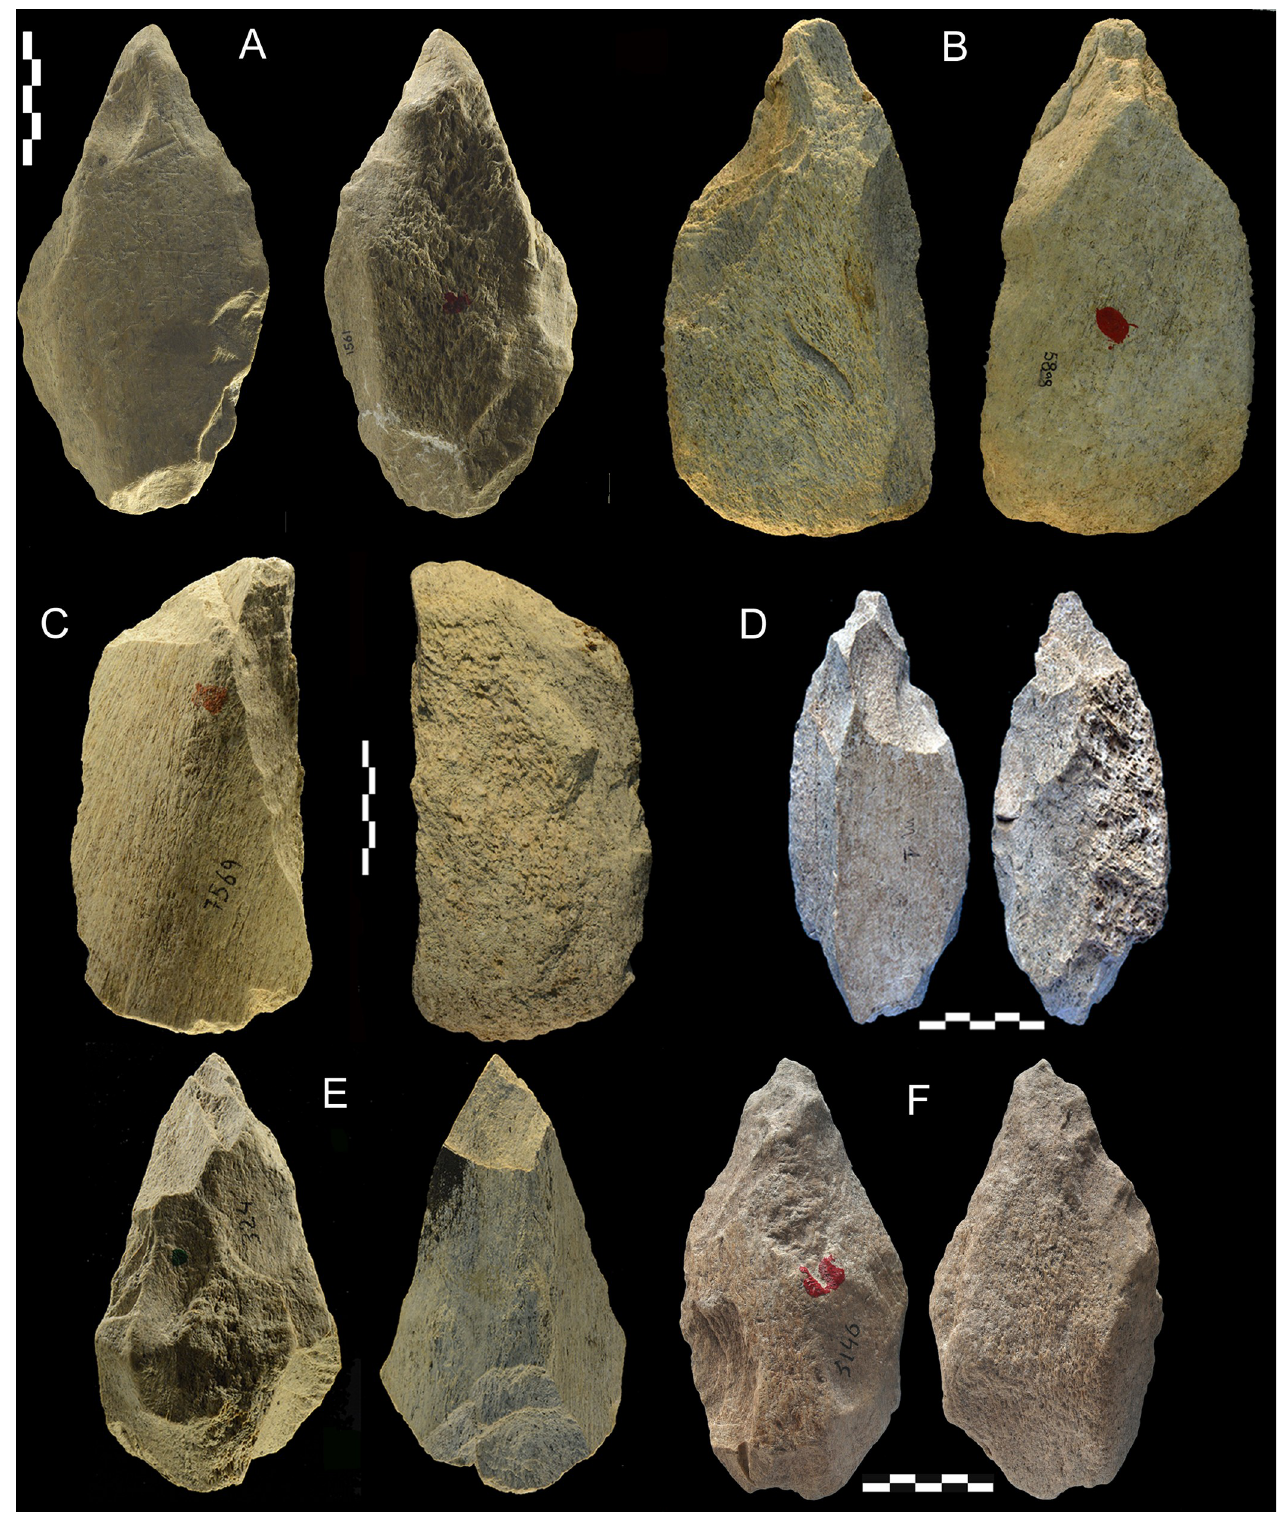
Fig 8. Castel di Guido. (A) biface; (B-F) partial bifaces. Catalogue numbers 1561, 5898, 7569, TM 10433, 324, 5146. Note that the partial bifaces B and E are abraded on one face and fresh or only slightly abraded on the other. This suggests that some large pieces were partly buried in sand and the exposed face (sometimes- but not always- indicated by a red or green dot assigned at excavation) was abraded in situ by the flow of sandy water. See similar occurrences in layer m of Torre in Pietra [34: p. 18]. Scale bar 5 cm. https://doi.org/10.1371/journal.pone.0256090.g008 PLOS ONE | https://doi.org/10.1371/journal.pone.0256090 August 26,